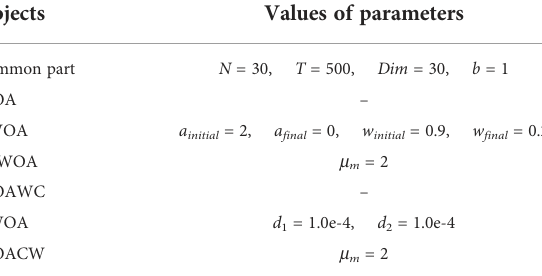
small, mainly including convolutional layers, pooled layers and fully connected layers. The alternating settings of convolutional and pooling layers in the model can abstract the input images into a set of feature maps through multiple nonlinear transformations, then the neurons of the fully connected layers are used to classify these features. The network structure of the LeNet-5 model is shown in Figure 2. The fi rst core part of the CNN is the convolutional layer, which performs convolutional calculations on the input data so that the complex features of the image can be fully described. The correspondence between the input and output of the convolutional layer is shown in Eq. 29.